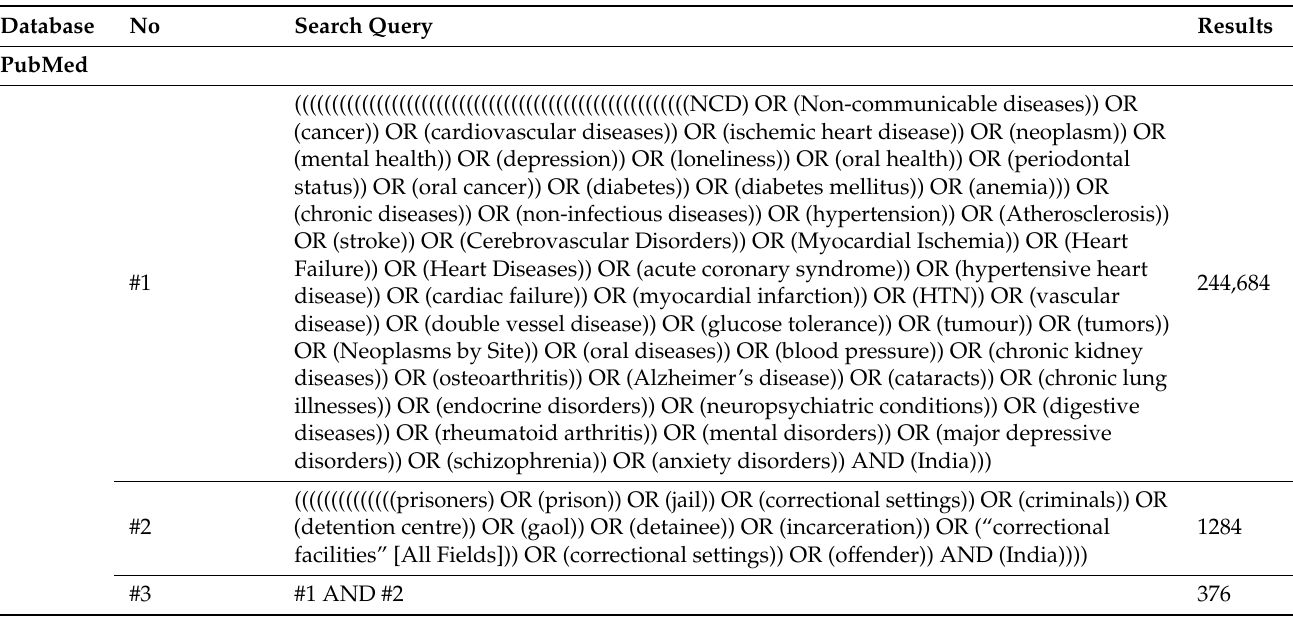
Table A1. The adjusted search terms as per searched electronic